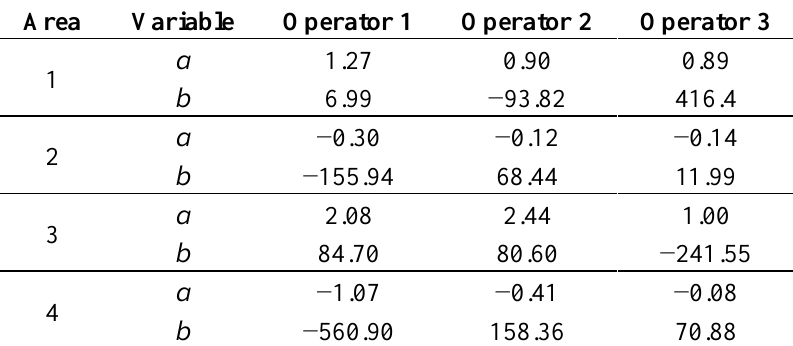
Table 3. Constant variables for reference